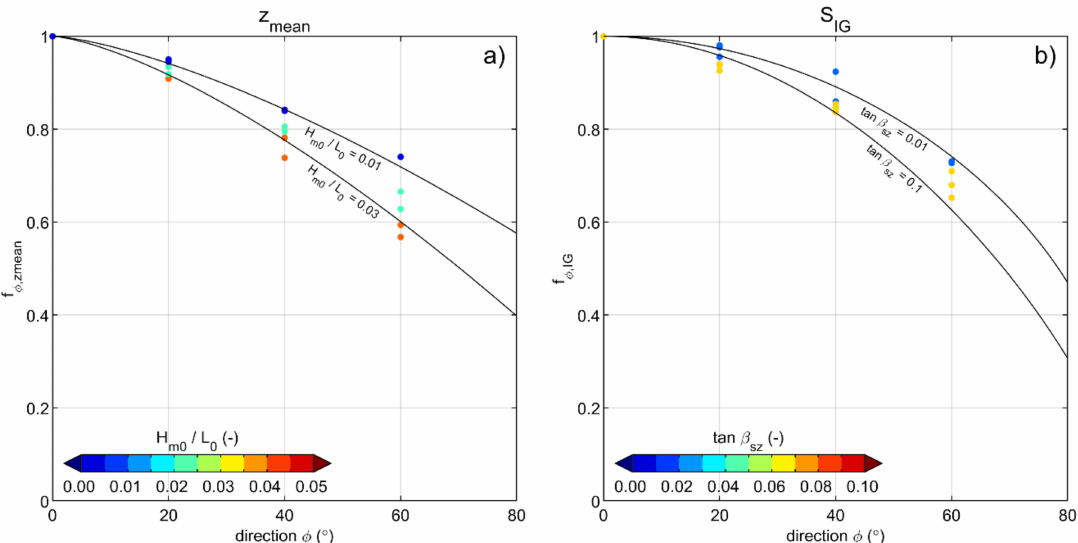
Figure 12. Computed wave angle reduction factors f ϕ for set-up ( a ) and infragravity run-up ( b ). Solid lines in ( a ) show the empirical fit with offshore wave steepness of 0.01 and 0.03. Solid lines in ( b ) show the empirical fit surf zone slope of 0.01 and